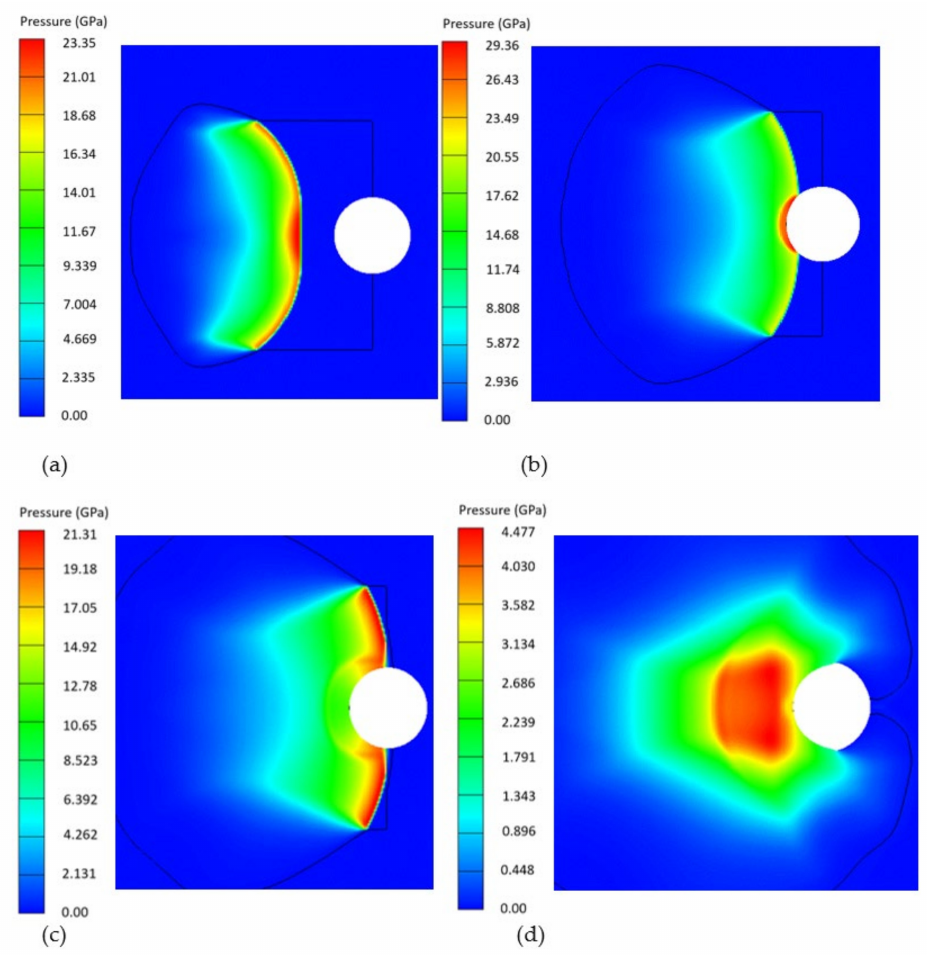
Figure 14. Simulated pressure contour plots from detonating a 27.16 g charge (30 mm diameter) embedded with a 10 mm diameter ball bearing at ( a ) 1.8 µ s, ( b ) 2.55 µ s, ( c ) 2.99 µ s, ( d ) 4.53 µ